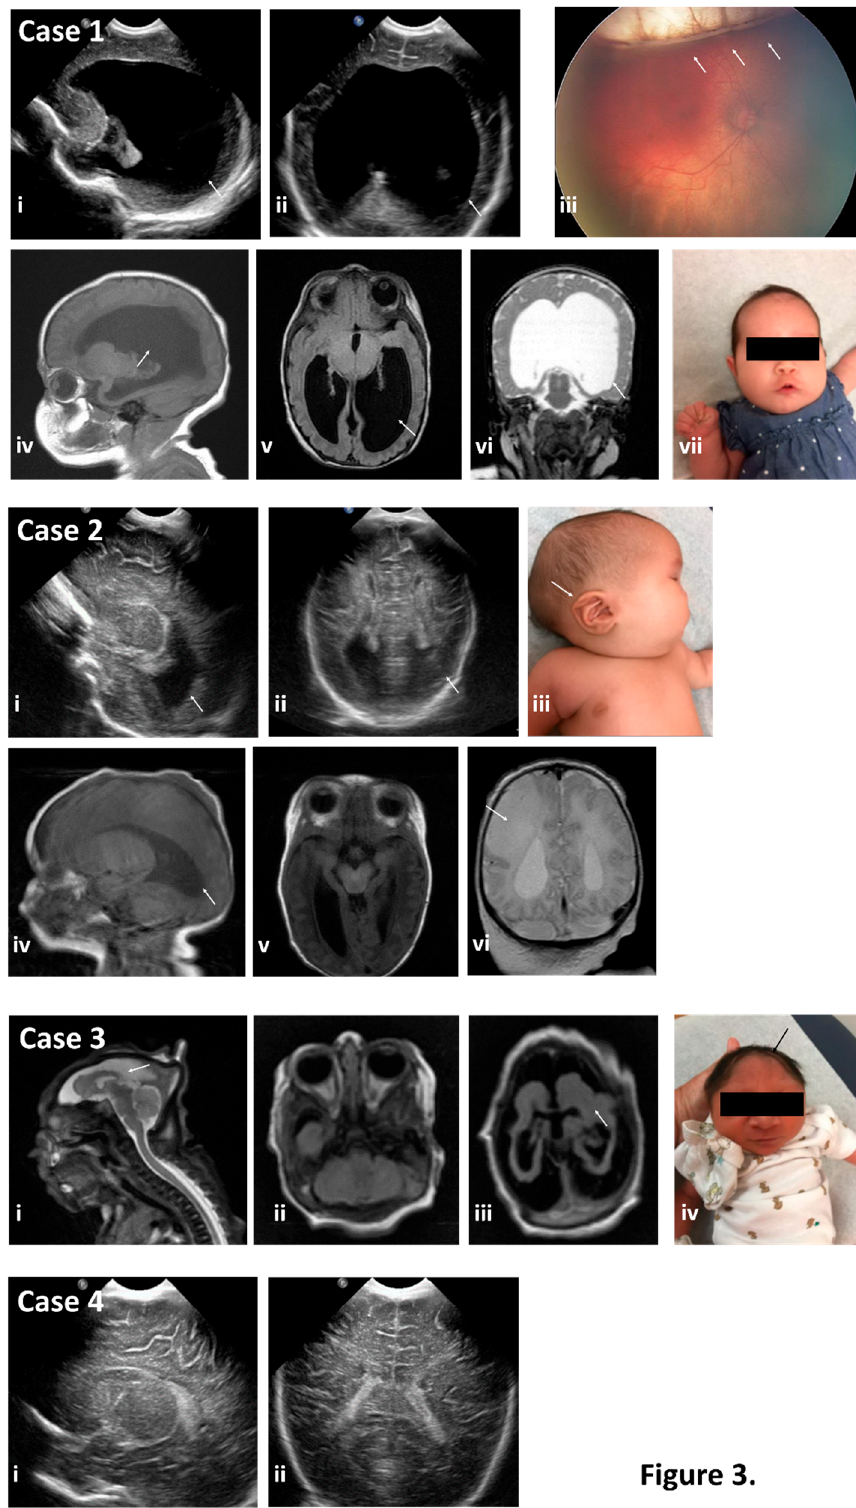
Figure 3. Neonatal physical exam findings consistent with a diagnosis of congenital Zika syndrome as identified by neonatal head ultrasound, postnatal MRI, gross presentation, and ophthalmic examination for the cases where detailed examination was warranted and subjects returned for postnatal care. Case 1 exhibited severe ventriculomegaly (arrows in images i and ii) by neonatal head ultrasound and as confirmed by post-natal MRI (arrows in images iv, v, and vi), despite the fronto- occipital head circumference (FOC) being normal (54th percentile) (image vii). Ophthalmic examination revealed bilateral colobomatous lesions consistent with congenital Zika syndrome